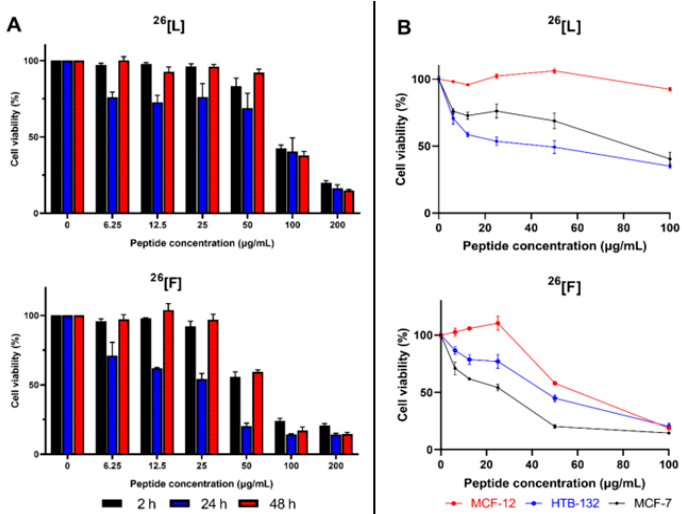
Figure 2. Cytotoxic effect of peptides 26 [L] and 26 [F] against MCF ‐ 7 cell lines. The MCF ‐ 7 cells were Figure 2. Cytotoxic e ff ect of peptides 26 [L] and 26 [F] against MCF-7 cell lines. The MCF-7 cells were treated with the peptides for 2, 24, or 48 h at 37 °C (Panel A ). Comparative cytotoxic effect of peptides treated with the peptides for 2, 24, or 48 h at 37 ◦ C (Panel A ). Comparative cytotoxic e ff ect of peptides 26 [L] and 26 [F] against MCF ‐ 7, HTB ‐ 132 and MCF ‐ 12 Cell lines; cells were treated with the peptides for 26 [L] and 26 [F] against MCF-7, HTB-132 and MCF-12 Cell lines; cells were treated with the peptides for 24, at 37 °C (Panel B ). The data represent the mean ± SE (Three independent experiments with n = 4 each) Statistically significant differences were found in the cytotoxic effect against the breast cancer 24, at 37 ◦ C (Panel B ). The data represent the mean ± SE (Three independent experiments with n = 4 lines and the non ‐ tumorigenic line MCF ‐ 12 in a range of 0 to 100 μ g/mL for 26 [L] and in a range of 0 each) Statistically significant di ff erences were found in the cytotoxic e ff ect against the breast cancer to 50 μ g/mL for 26 [F]. (ANOVA, Sidak’s multiple comparisons test was used, p ≤ 0.05). lines and the non-tumorigenic line MCF-12 in a range of 0 to 100 µ g / mL for 26 [L] and in a range of 0 to To determine if the cytotoxic effect of the peptide is selective for breast cancer cells, the human 50 µ g / mL for 26 [F]. (ANOVA, Sidak’s multiple comparisons test was used, p ≤ 0.05). immortalized non ‐ tumor epithelial cell line MCF ‐ 12 was treated with the peptides 26 [F] and 26 [L]. This cell line has been used as a control of normal cells in previous studies of breast cancer [22,23]. The Cell morphology was monitored before and after treatment with 26 [L] or 26 [F] at di ff erent peptides 26 [L] and 26 [F] exhibited a lower cytotoxic effect against MCF ‐ 12 cells than against breast cancer cell lines HTB ‐ 132 and MCF ‐ 7 (Figure 2B). The peptide 26 [L] exhibited a selective cytotoxic effect in a peptide concentration range between 6 and 100 μ g/mL, The IC 50 values for peptide 26 [L] in HTB ‐ 132 (10 μ M/32 μ g/mL) and MCF ‐ 7 (20 μ M/26 μ g/mL) was less than the IC 50 value in the non ‐ tumorigenic cell line MCF ‐ 12 (>100 μ g/mL). The peptide 26 [F] exhibited the greatest selectivity for MCF ‐ 7 cells when the peptide concentration was between 6 and 50 μ g/mL. The IC 50 values for peptide 26 [F] in HTB ‐ 132 (13 μ M/43 μ g/mL) and MCF ‐ 7 (6 μ M/19 μ g/mL) was less than the IC 50 value in the non ‐ tumorigenic cell line MCF ‐ 12 (21 μ M/ 70 μ g/mL). When the peptide concentration was 6 μ M, the